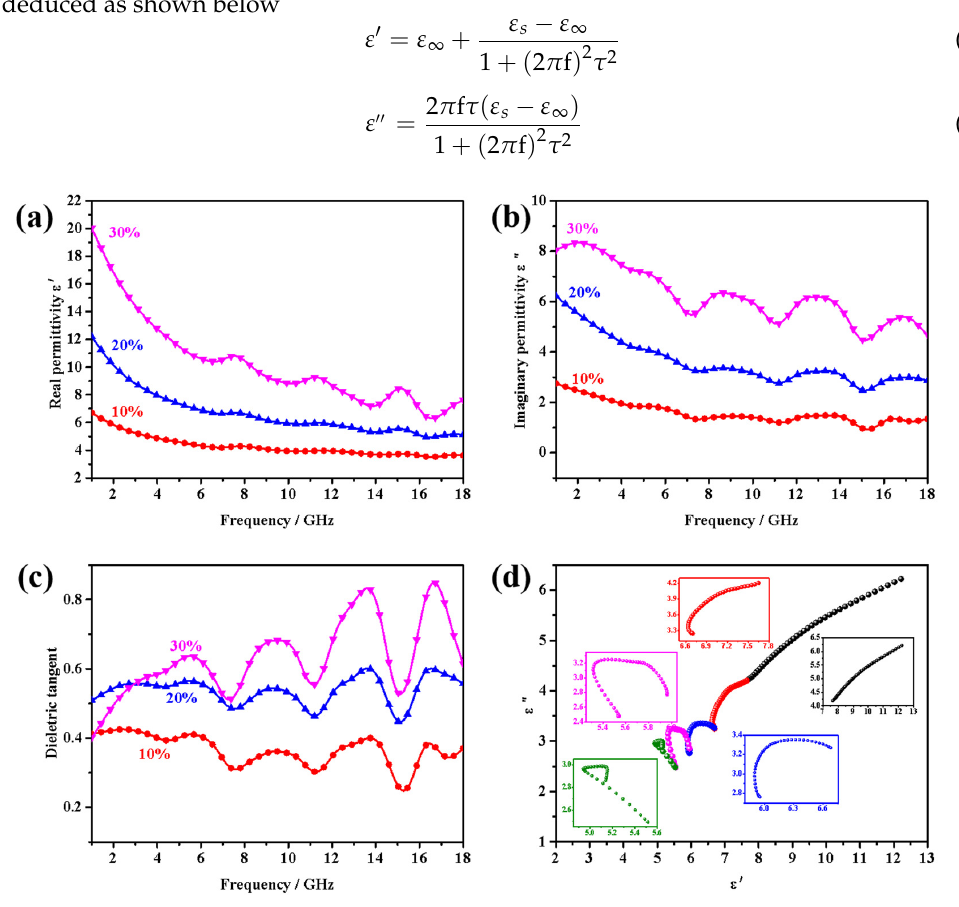
Figure 9. Frequency dependence of the real and imaginary parts of complex permittivity ( a , b ) dielectric loss tangent ( c ) of different samples and the Cole–Cole plots of samples with mass fraction of 20 wt% ( d ).